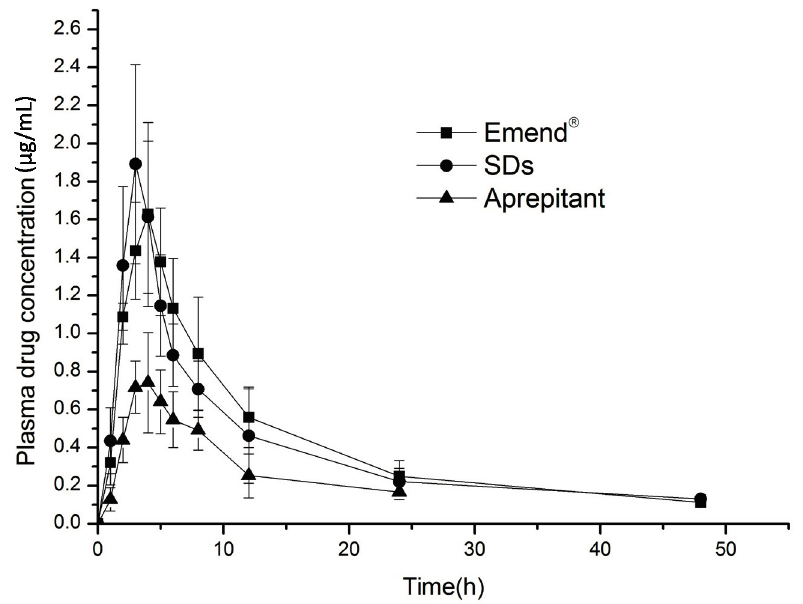
Figure 6. Plasma concentration-time profiles following oral administration of solid dispersions and Emend ® ( n = 6).